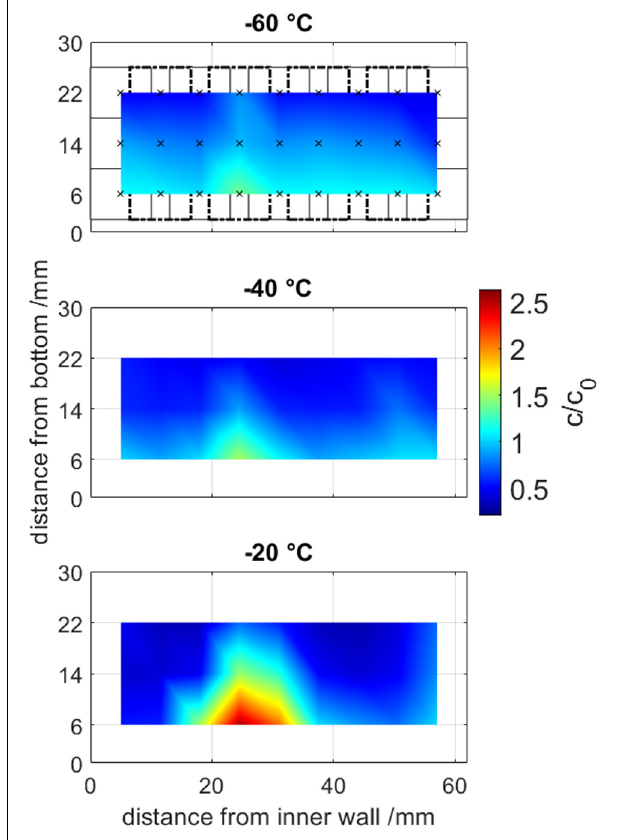
FIGURE 5 | Offline sample analysis from frozen drill cores at temperatures from –60 to –20 ◦ C. Samples volumes are visualized in the first graph in solid and dashed rectangles, where the center of a measurement is marked by an x. Normalized concentration are visualized by a color gradient from blue to red and are interpolated between the averages from triplicates ( n = 3).